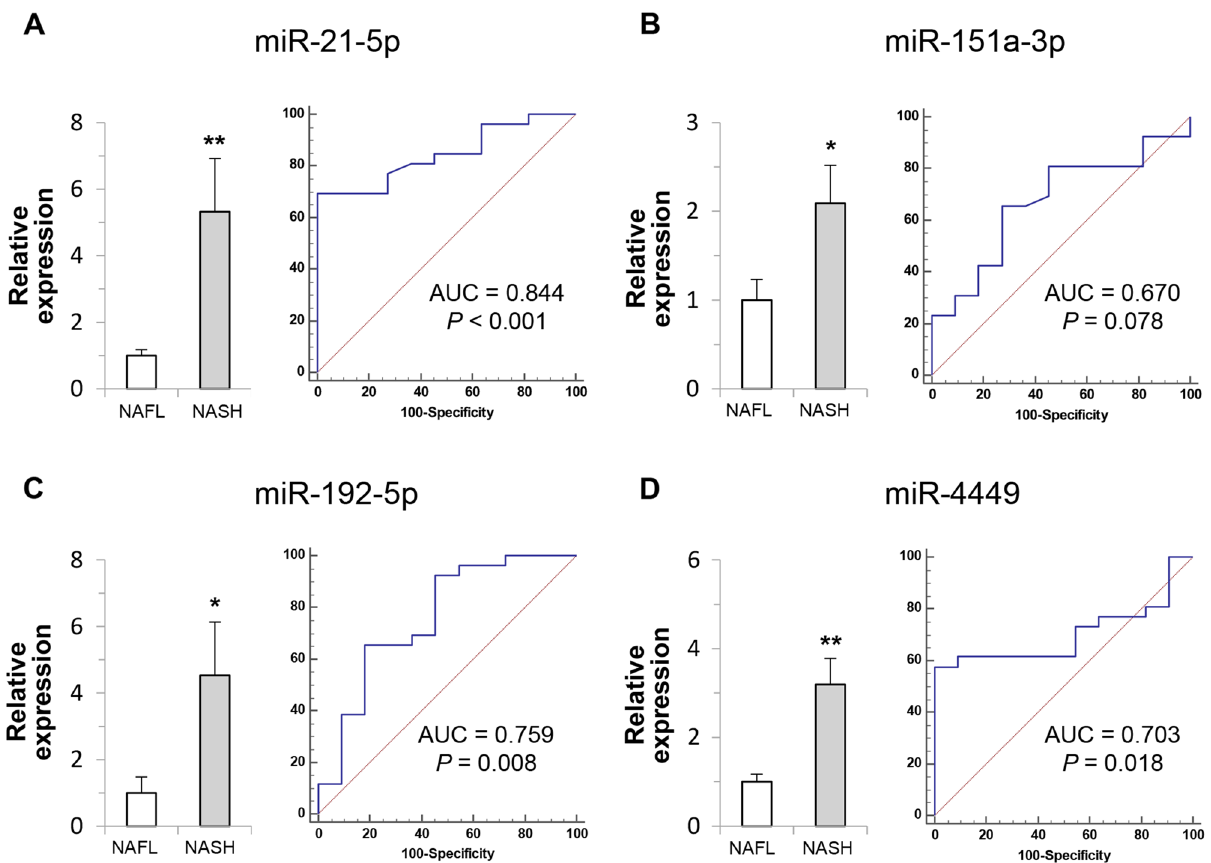
Figure 3. Expression level and diagnostic receiver operating characteristic (ROC) curve for NASH diagnosis of four miRNAs (miR-21-5p, miR-151a-3p, miR-192-5p, and miR-4449) in validation cohort. Expression level of each miRNA is normalized to small nuclear RNA U6 expression value and represents 2 -∆∆Ct . * Indicates P < 0.05 compared with the corresponding control. **Indicates P < 0.01 compared with the corresponding control.